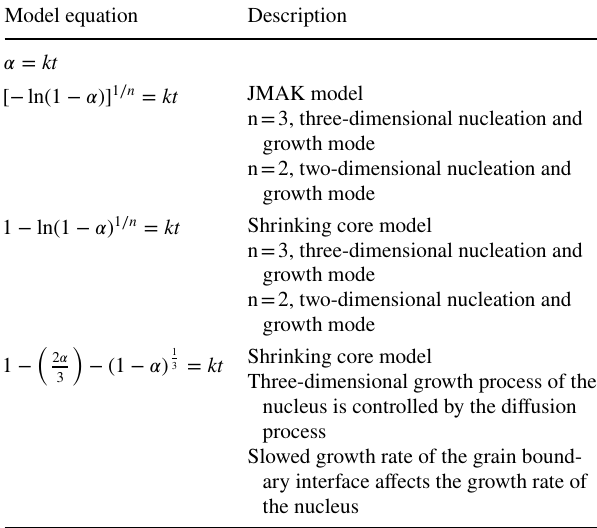
Table 1 Kinetic models for hydrogen absorption and desorption pro- cess Model